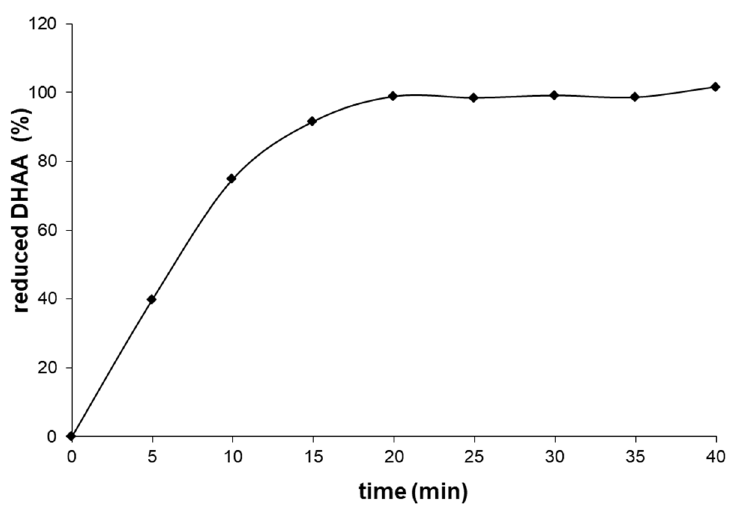
Figure 4. Degree of dehydroascorbic acid reduction versus time with the use of tris(2 − carboxyethyl)phosphine.